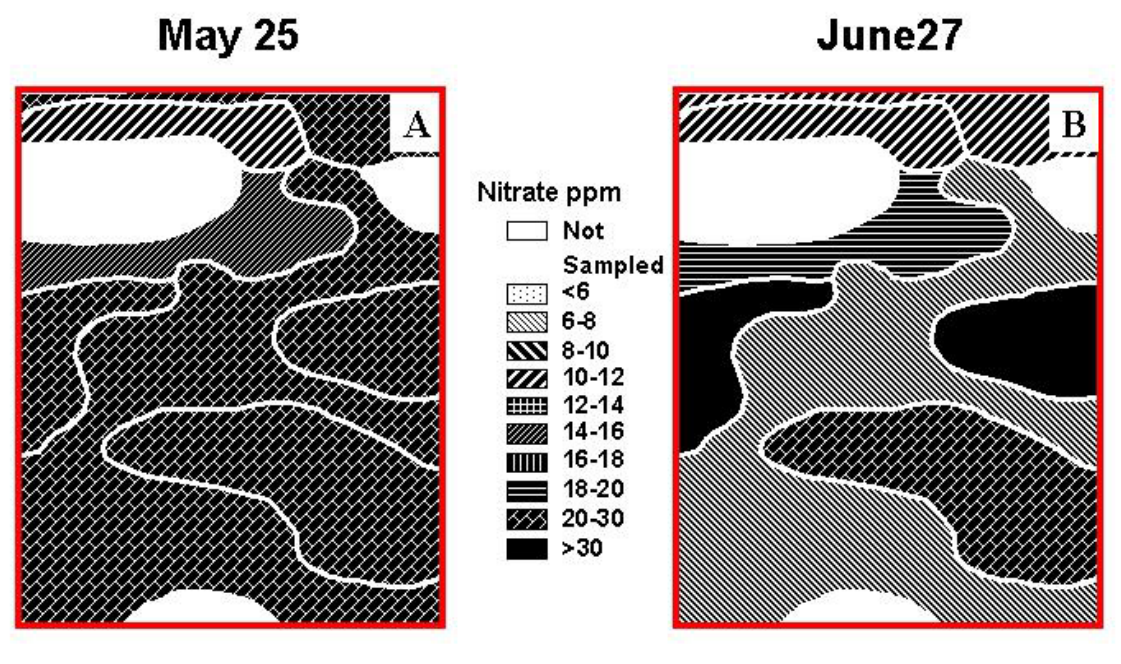
– -N] FIGURE 3. The [NO for a 33 ha field in western Minnesota on May 25 (A) and June 27 (B). Intense rainfall in early June leached much of the NO 3 15 large portions of the field. Lines represent soil mapping unit